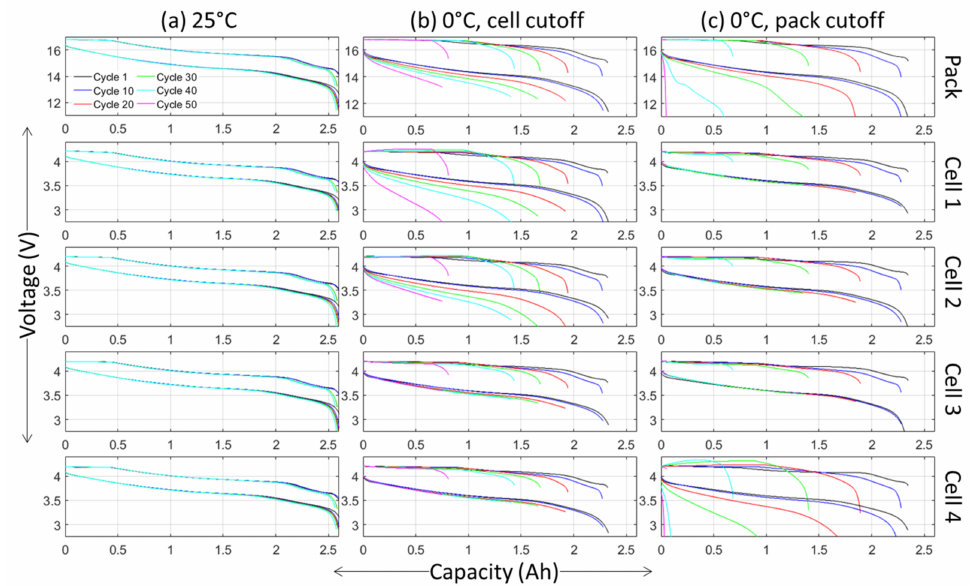
Figure 5. Individual cell charge and discharge data within the 4S packs for 1st, 10th, 30th & 50th cycles at three conditions: ( a ) 25 ◦ C; ( b ) 0 ◦ C with 2.75 V individual cell cutoff and ( c ) 0 ◦ C with 11.0 V pack voltage cutoff.